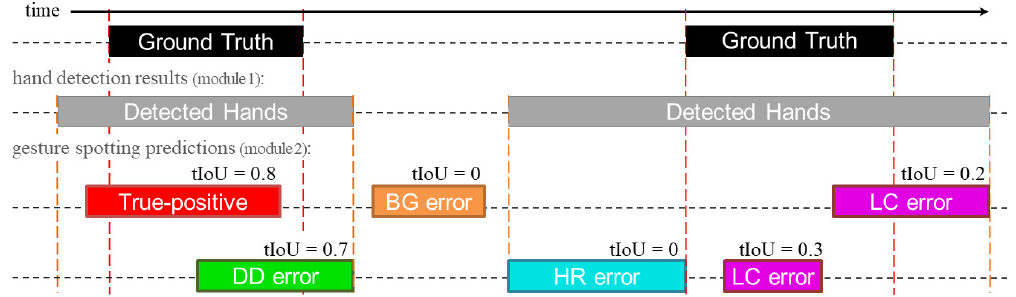
Figure 12. Examples of different types of false-positive errors: double-detection (DD), location (LC), hand-detection (HD), and background (BG). Note that the tIoU of each prediction is calculated with respect to their nearest